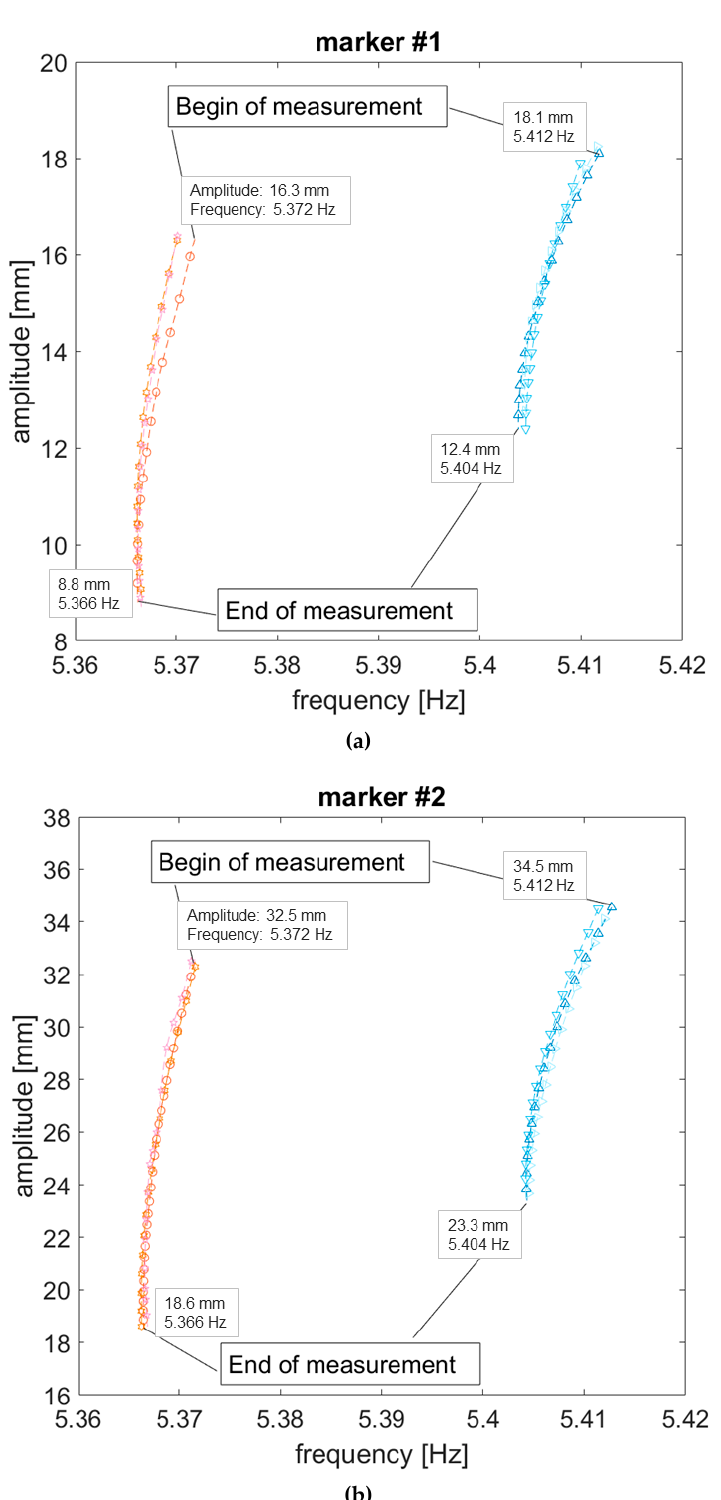
Figure 14. Comparison of backbone curves (loaded vs. unloaded condition) for ( a ) marker #1 and ( b ) marker #2, at their actual frequencies. Triangles in shades of blue correspond to the three measurements without sensors. The other red / pink markers refer to the three measurements with sensors attached.